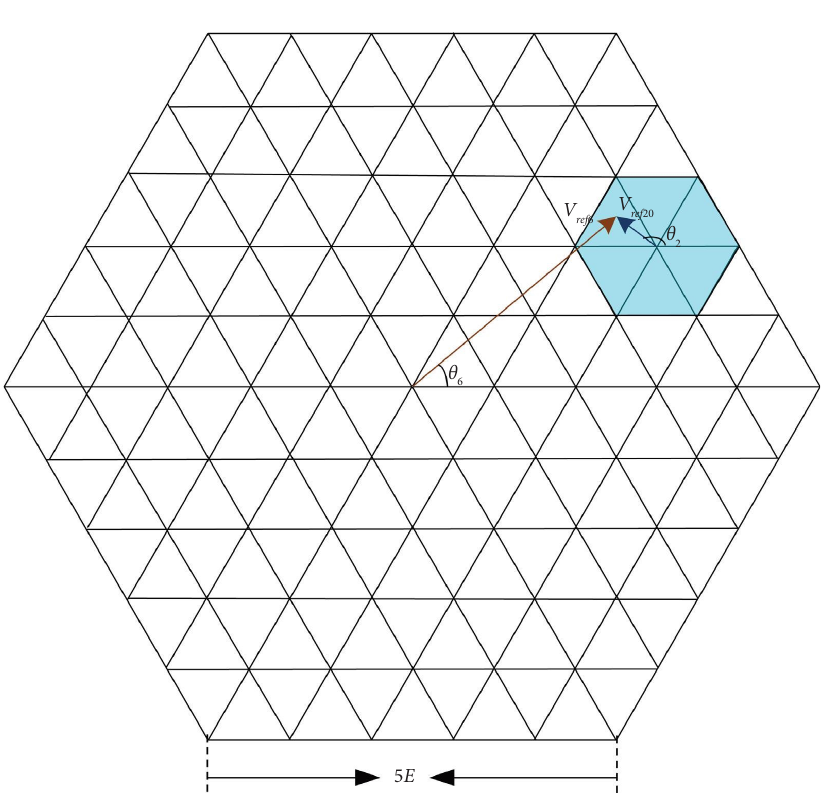
Figure 4: Mapping of V